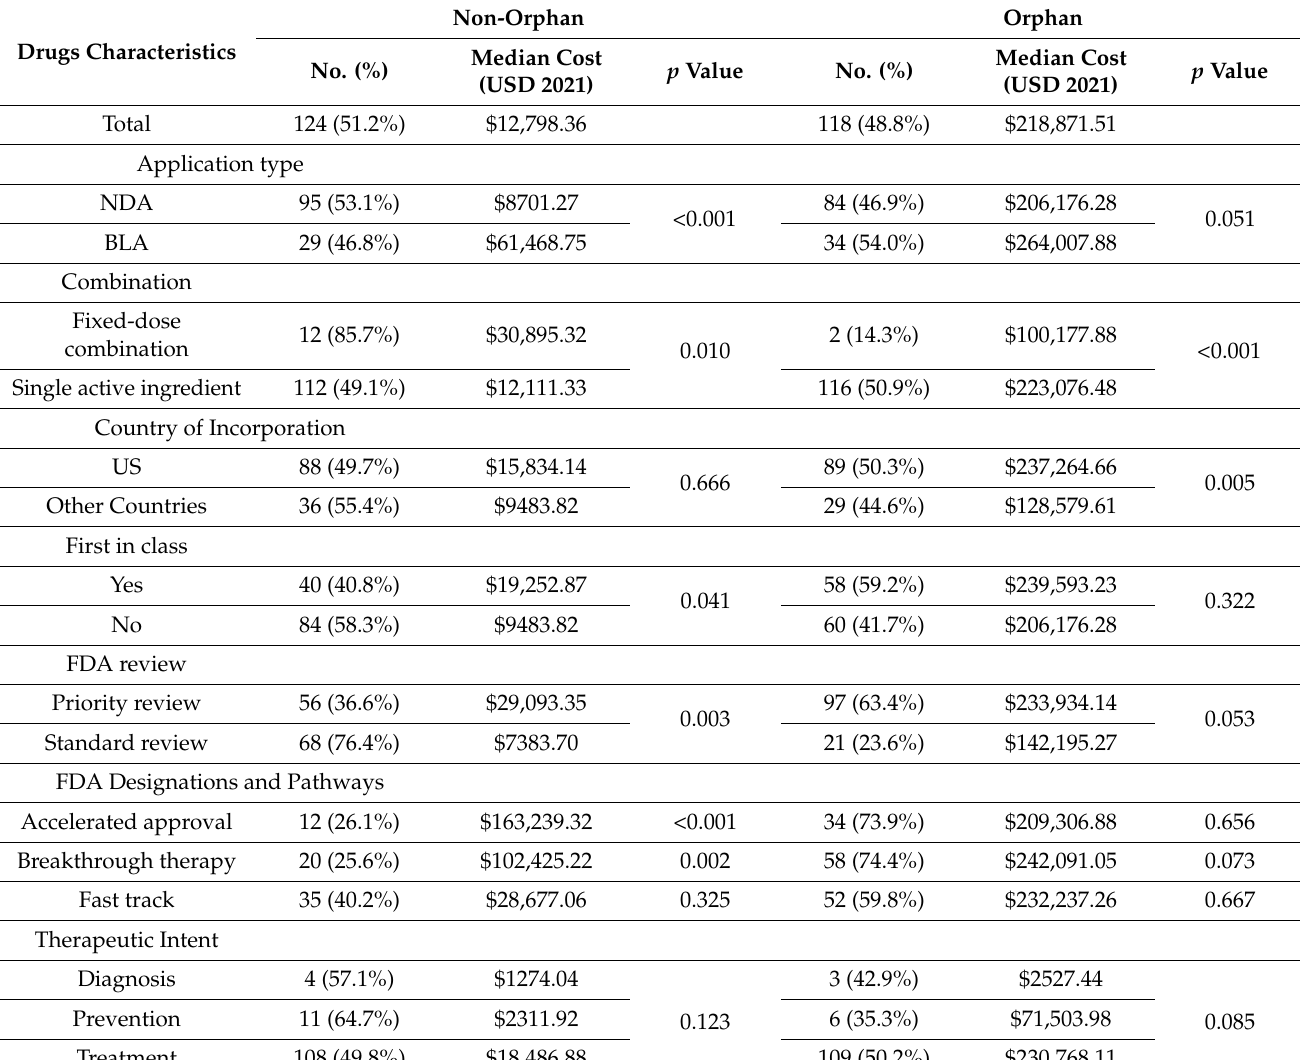
Table 1. Characteristics and median cost of new drugs and biological products approved by the US Food and Drug Administration,